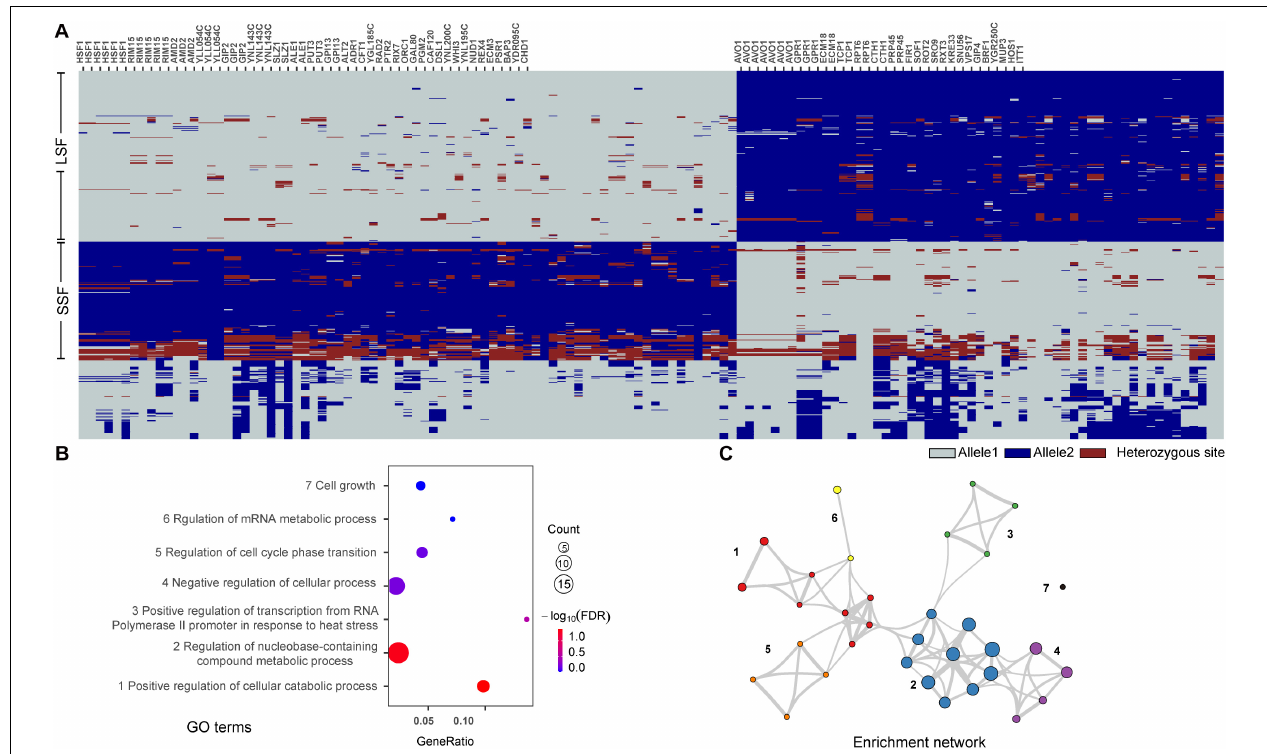
FIGURE 5 | Functions of genes with group specific allele distribution patterns in different domesticated groups of S. cerevisiae . (A) Distribution patterns of selected SNPs with alleles that were shared by more than 90% isolates in one domesticated group but not shared by more than 90% isolates in the other group. The genes with known functions harboring the SNPs are listed at the top. (B) GO terms enriched with the genes with group specific allele distribution patterns. (C) Enrichment networks show the intra- and intercluster functional similarities of the enriched GO terms shown in (B) . Enrichment networks are created by representing each enriched term as a node and connecting pairs of nodes with Kappa similarities above 0.3. The sizes of the nodes are proportional to the numbers of input genes fall into the